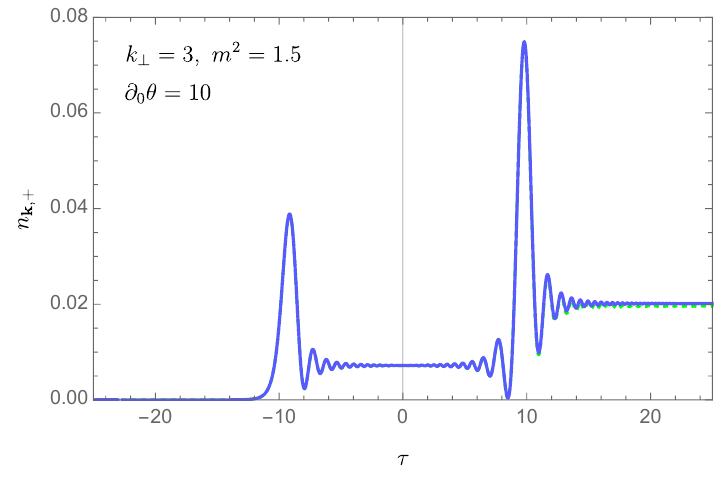
Figure 1 . n k , + is plotted fixing ∂ 0 θ , and changing τ . The blue solid line is the numerical solution of (2.33) under ∂ 2 θ = 0 , and the green dotted line is the numerical solution of (3.6). The origin of 0 the time coordinate is set at ¯ k 3 = 0 . The parameters are expressed in the eE = 1